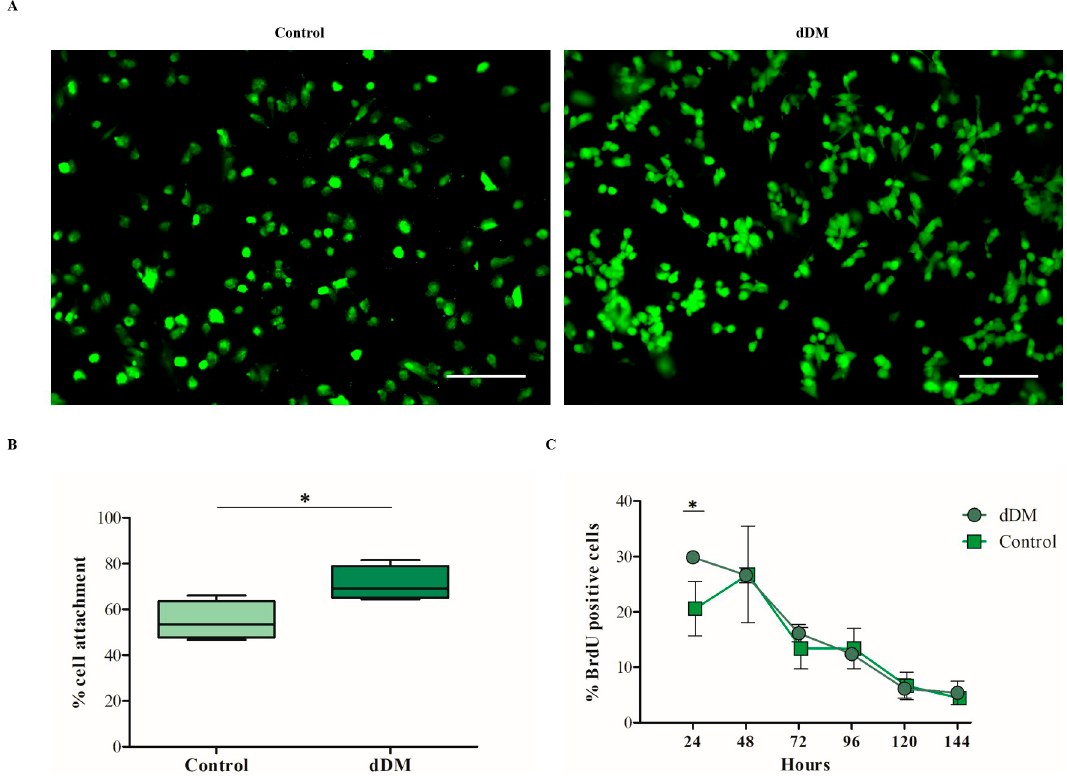
Fig 4. Decellularized Descemet’s membrane provides optimal cues for hESC-RPE cell initial attachment and proliferation. ( A ) Immunofluorescence for Calcein AM ( green ) allows the visualisation of viable hESC-RPE cells 24 hours post-seeding on dDM and in control condition. Scale bars = 100 μ m. ( B ) Percentage of initial cell attachment on dDM compared to control. Each box represents mean ± s.d. for fourfold experiments. � p = 0.028. ( C ) The graph shows the percentage of proliferative BrdU-positive cells on dDM and on TC insert at different time points during the first week of culture. Each time point represents mean ± s.d. for triplicate experiments. � p = 0.032.